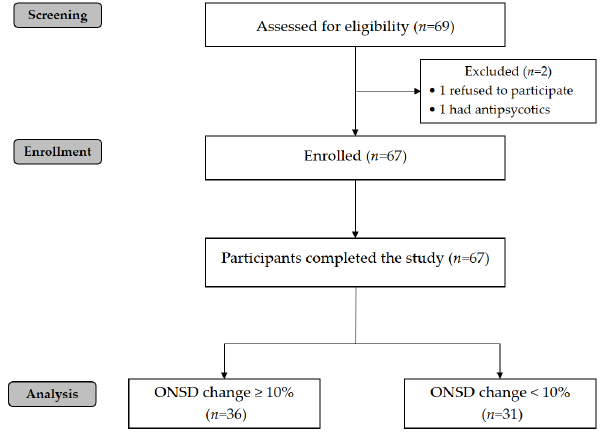
Figure 2. STROBE flow chart of participants. STROBE, Strengthening the Reporting of Observational Studies in Epidemiology formatting. Table 1. Patient characteristics and perioperative data.